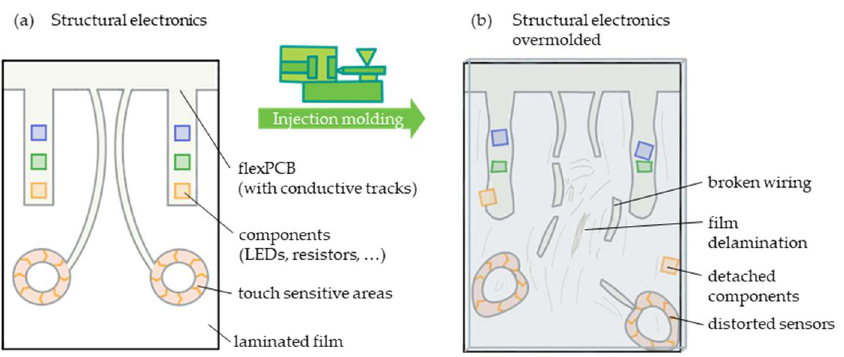
Figure 1. Sketch of a structural electronics part with possible features ( a ) and possible defects after overmolding ( b ).